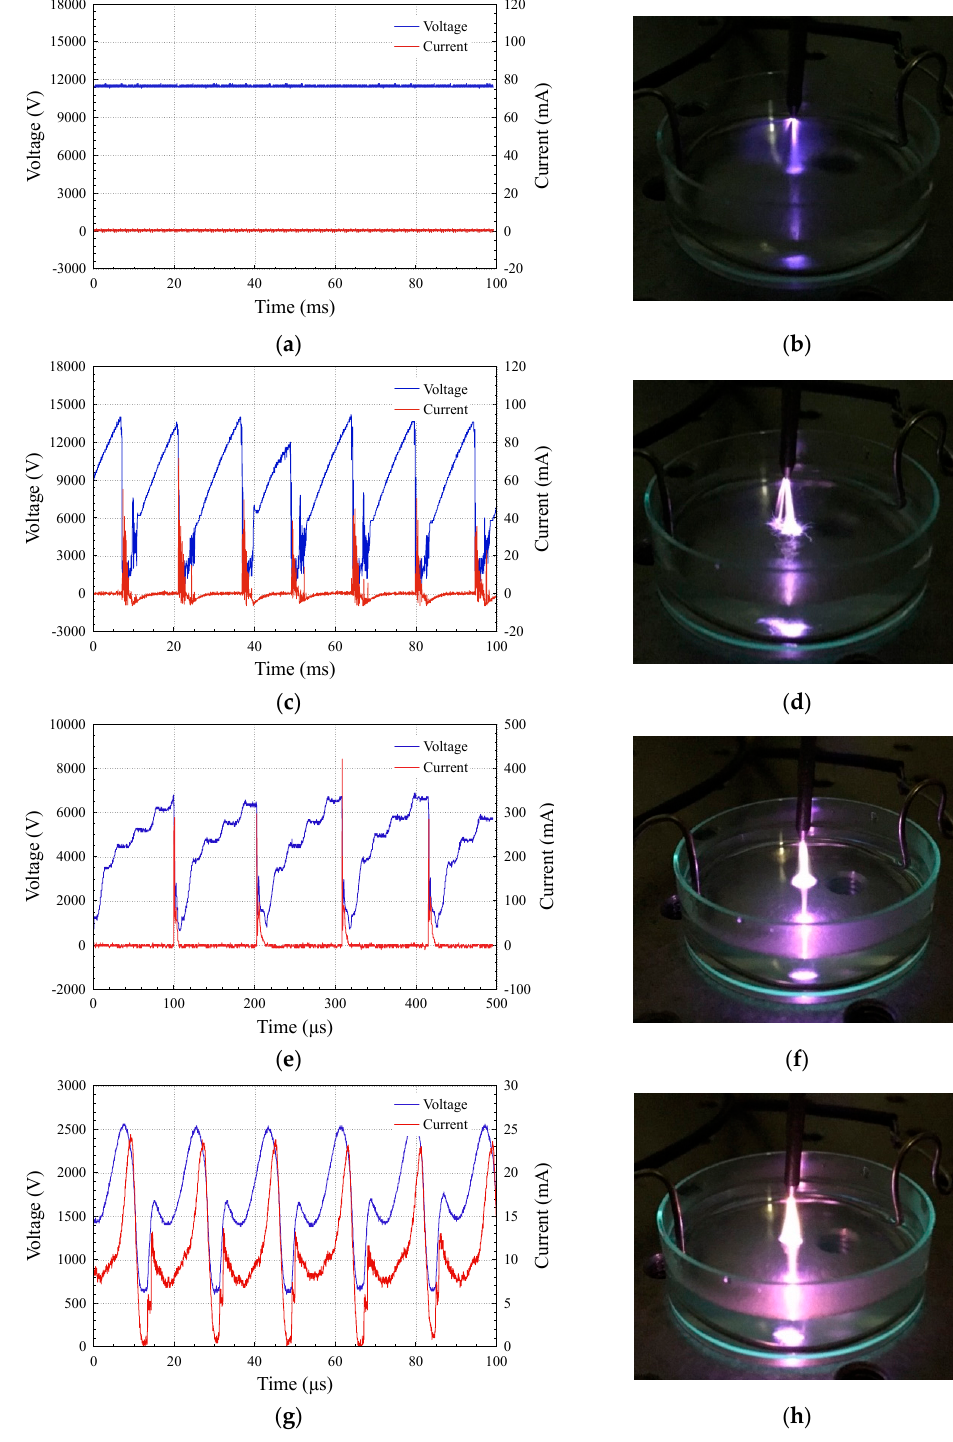
Figure 2. I & V waveforms ( a ) and photo ( b ) of corona discharge, I and V waveforms ( c ) and photo ( d ) of spark discharges at 9.5 W of input power, I and V waveforms ( e ) and photo ( f ) of spark discharges at 23 W of input power, and I & V waveforms ( g ) and photo ( h ) of ambient air low-current arc (AALCA) at 25 W of input power.